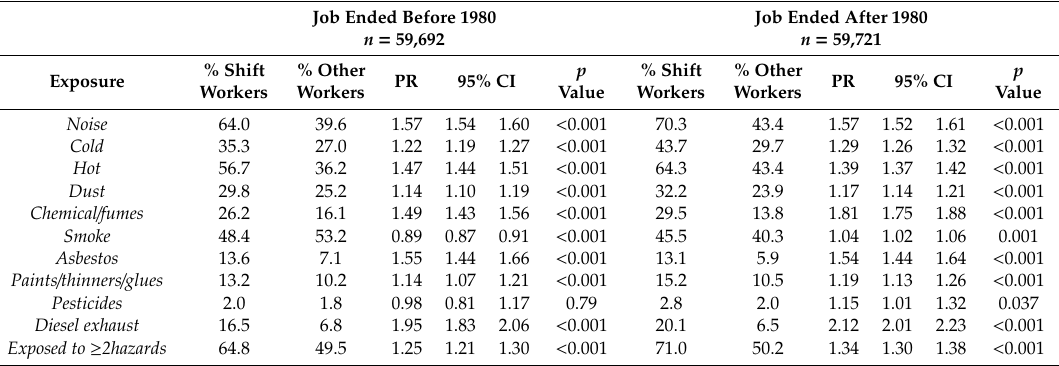
Job Ended After 1980 n = 59,721